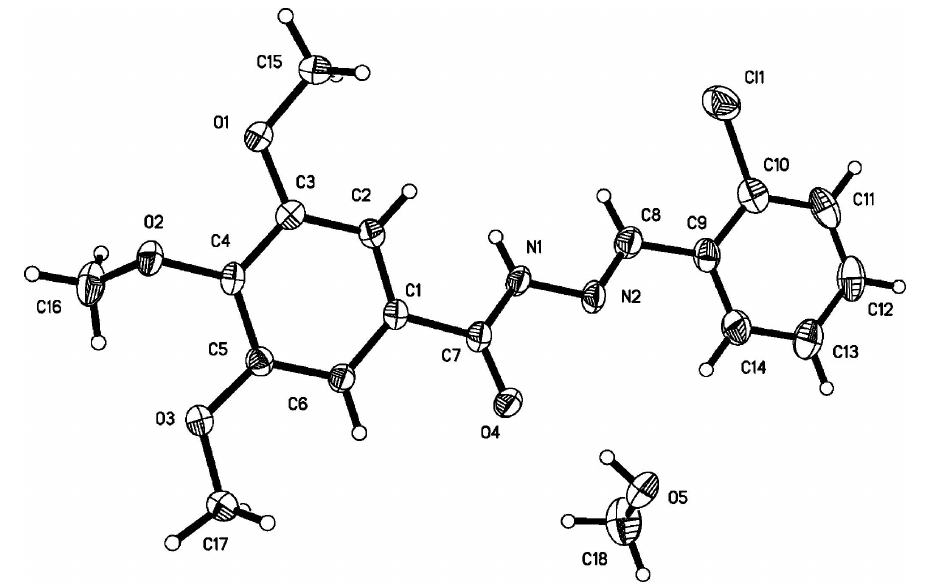
Figure 1 The molecular structure of (I) with displacement ellipsoids for the non-hydrogen atoms drawn at the 50% probability